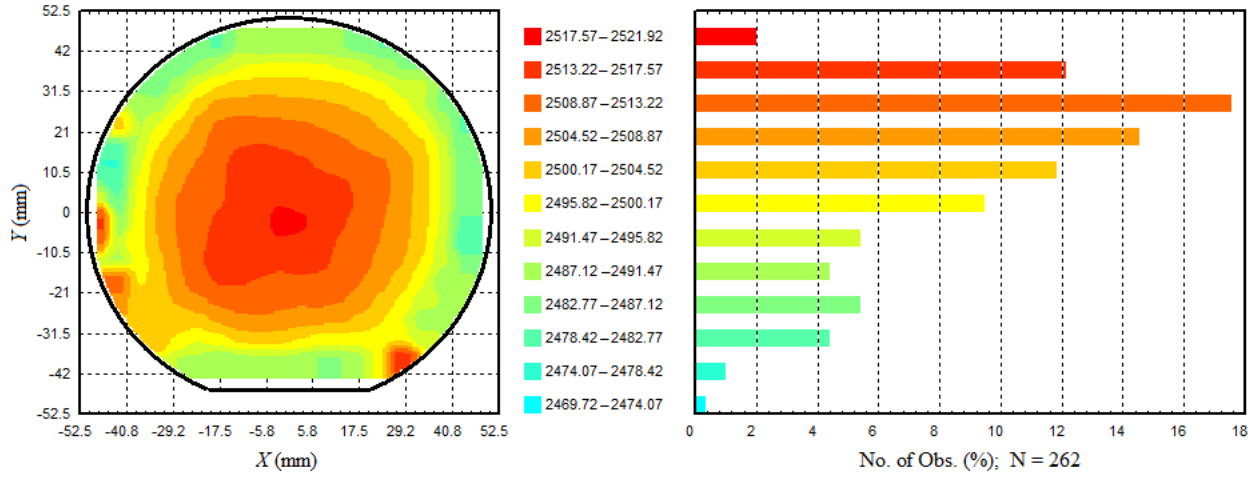
Figure 7. Thickness and uniformity of thickness of a thick SiON film obtained by micro-spot spectroscopic reflectometry. N is the number of points measured on the wafer.